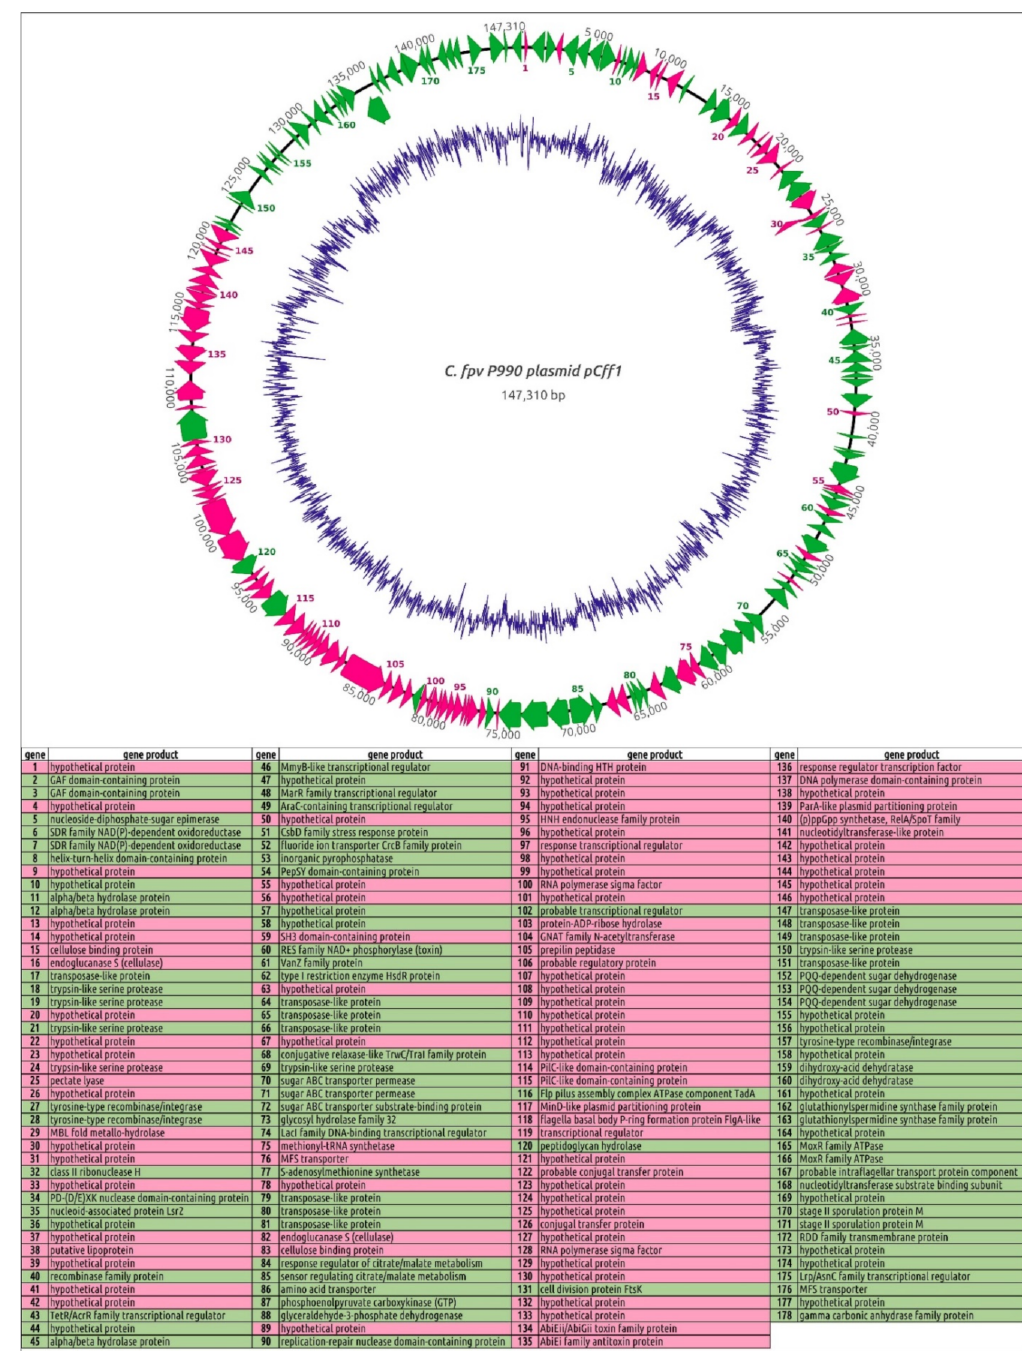
Figure 6. Circular genomic map and functional assignments of the Curtobacterium flaccumfaciens pv. flaccumfaciens P990 plasmid pCff1. In total, 178 protein-coding genes are shown as coloured blocks. The genes found in genomes of strains with confirmed pathogenicity in 50% or more of the total BLASTP search results on 190 Curtobacterium genomes are coloured green. The other genes are coloured light magenta. The direction of transcription is shown by arrows. The GC content of the genome sequence is indicated by the internal blue